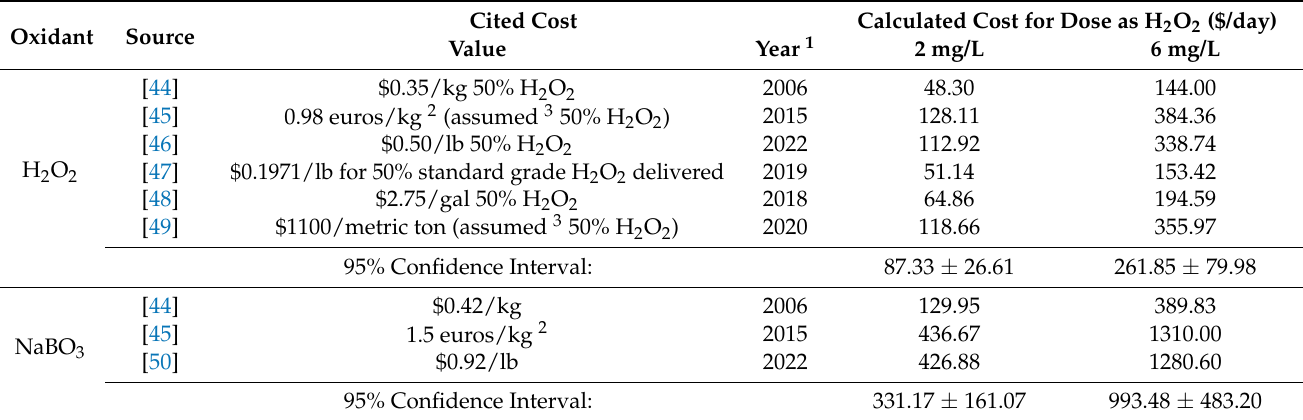
Table 4. Calculated Chemical Costs for H 2 O 2 and NaBO 3 Bulk Shipments.